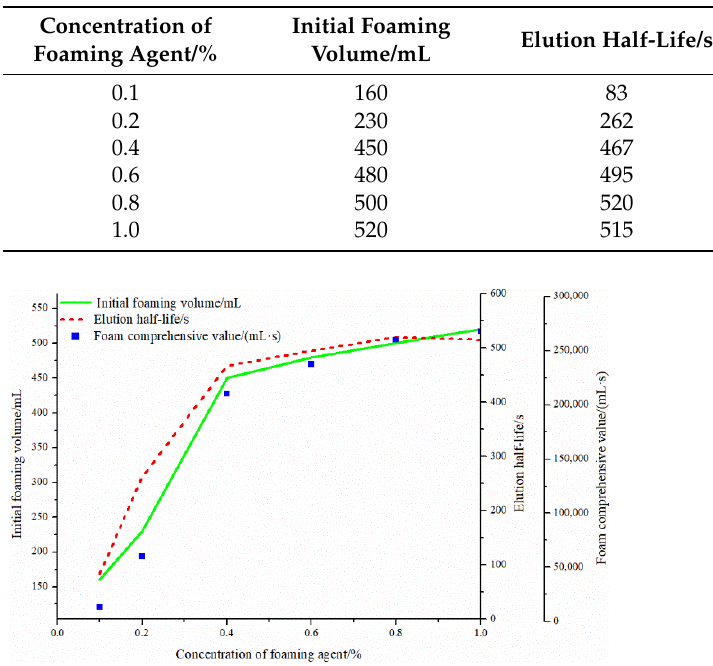
Figure 7. Concentration of foaming agent-initial foaming volume, foam half-life, and composite value.